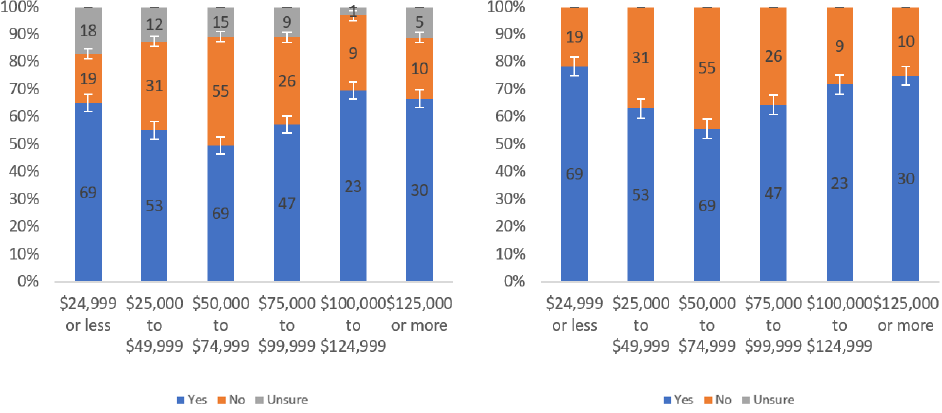
Figure 55. Responses regarding label helpfulness by income level including ( left ) and excluding ( right ) unsure responses.